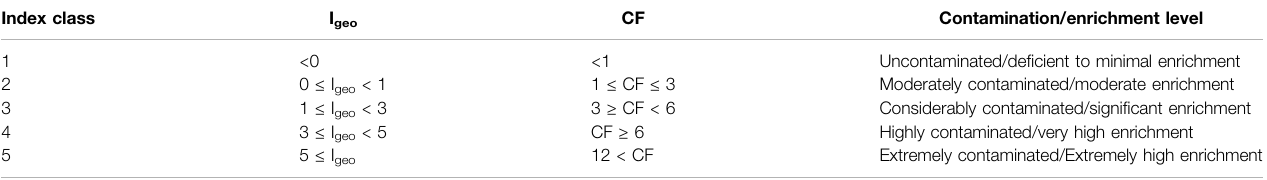
TABLE 1 | Classi fi cation of contamination levels based on calculated geochemical indices [Adapted from Barbieri (2016), Wu et al. (2014)]. Index class